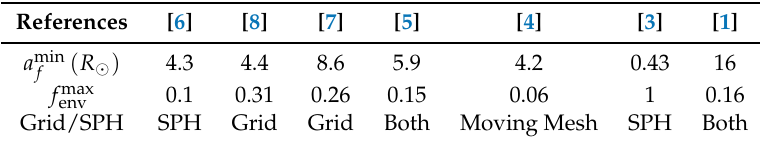
Table 1. Comparison between results from common envelope evolution simulations. a min minimal final separation achieved in each paper and f max env denotes the maximal fraction of the envelope ejected in each paper. The fourth row states the numerical technique used in each paper, i.e., grid code or smoothed-particle hydrodynamics (SPH)